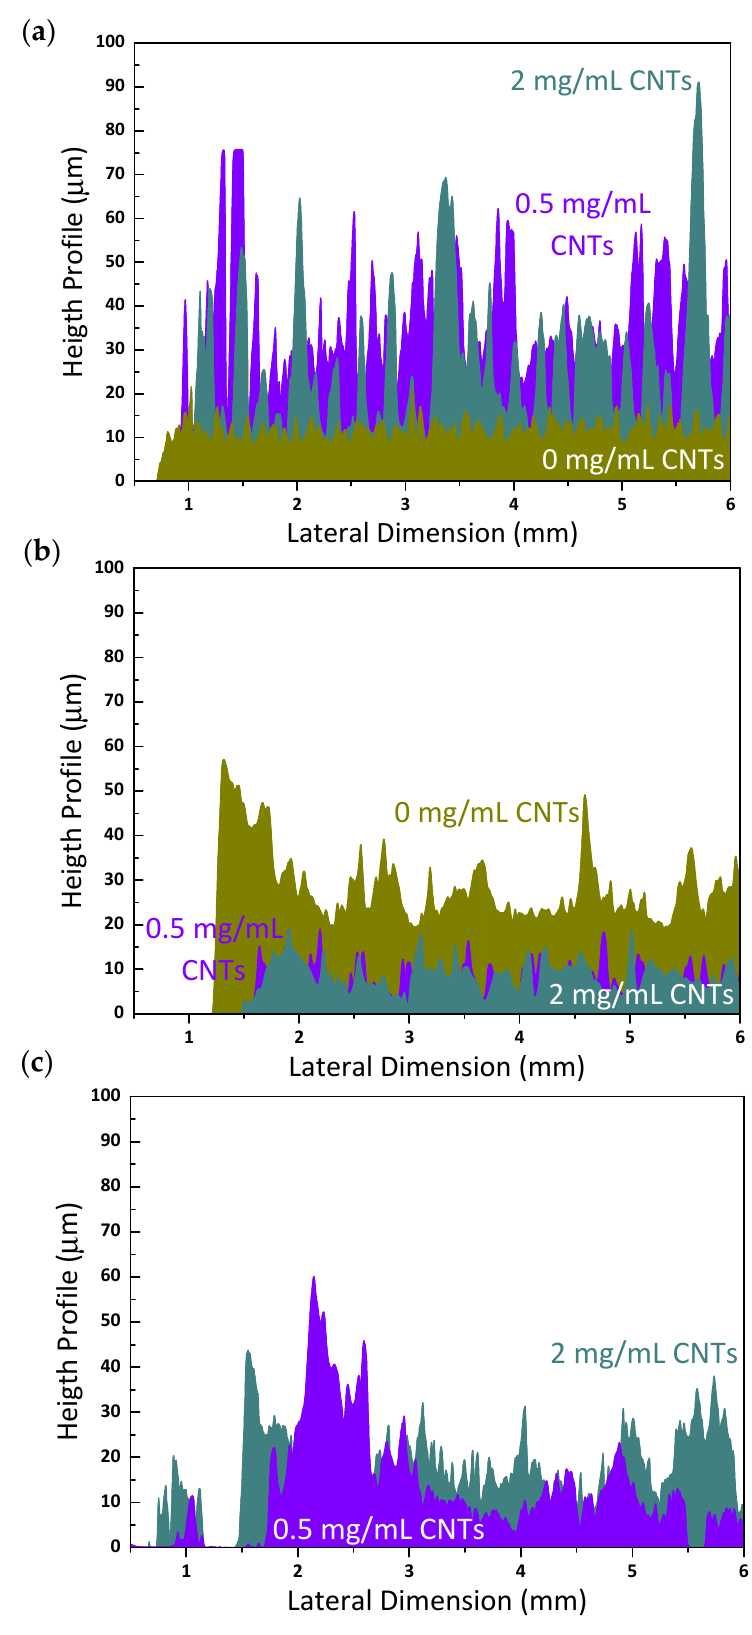
Figure 7. Topographic profiles across 6 mm distance for films made from inks with type I NCC ( a ), from inks with type II NCC ( b ) and from pastes with type I NCC ( c ), at the indicated CNT ratio in the initial formulation. All samples came from formulations with 2 mg/mL GO and 5 mg/mL NCC.